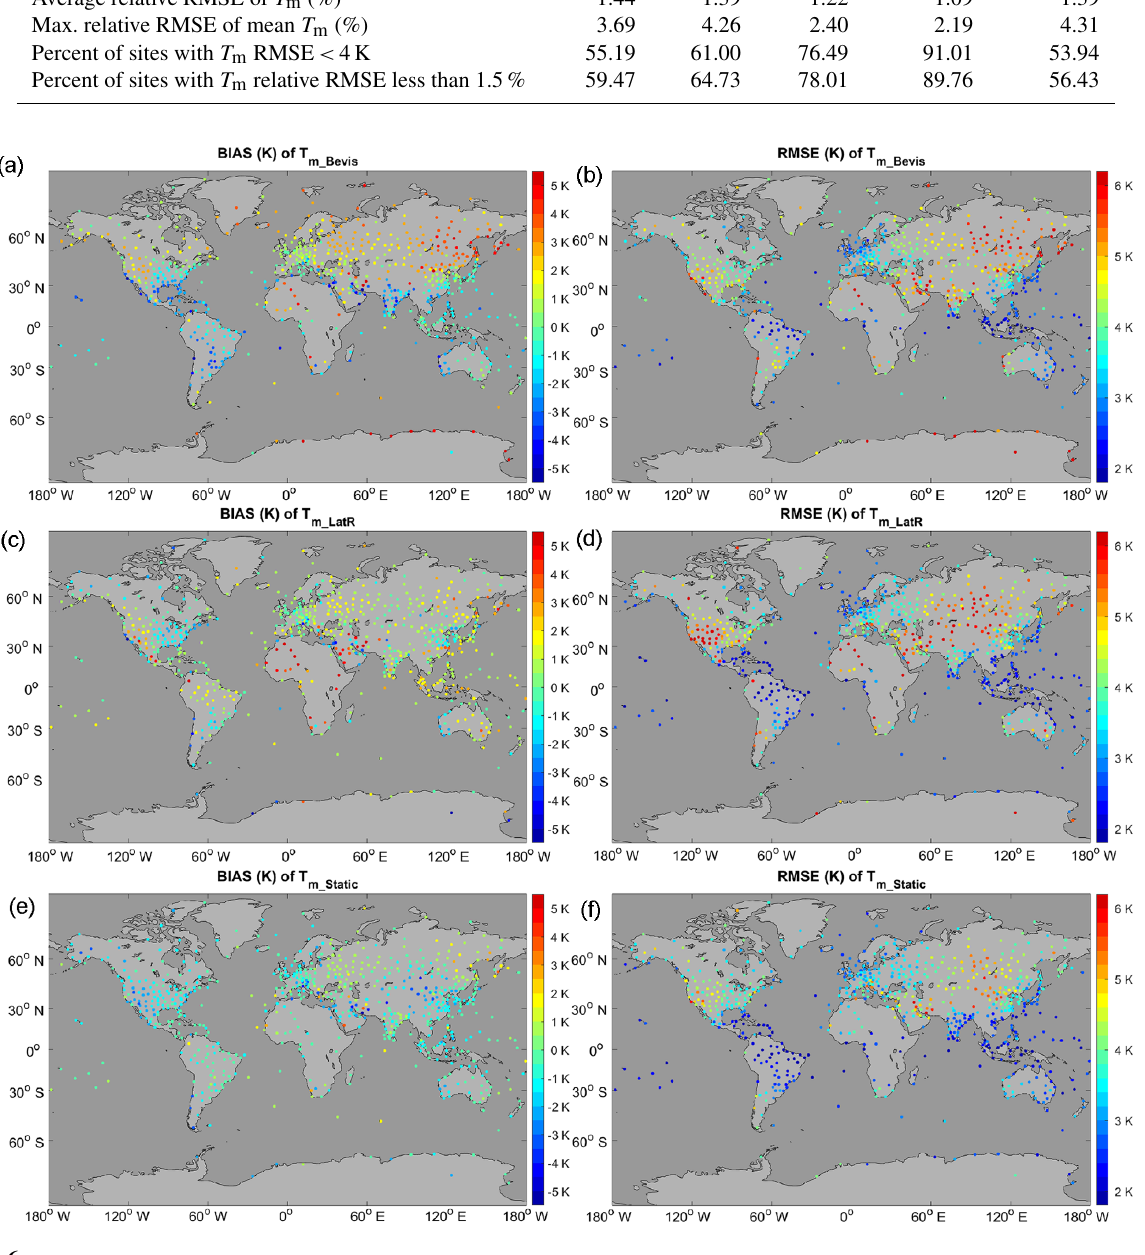
2. ANOVA is a technique used to analyze the differences among group means (Hogg and Ledolter, 1987). It eval- uates the null hypothesis that the samples all have the same mean against the alternative that the means are